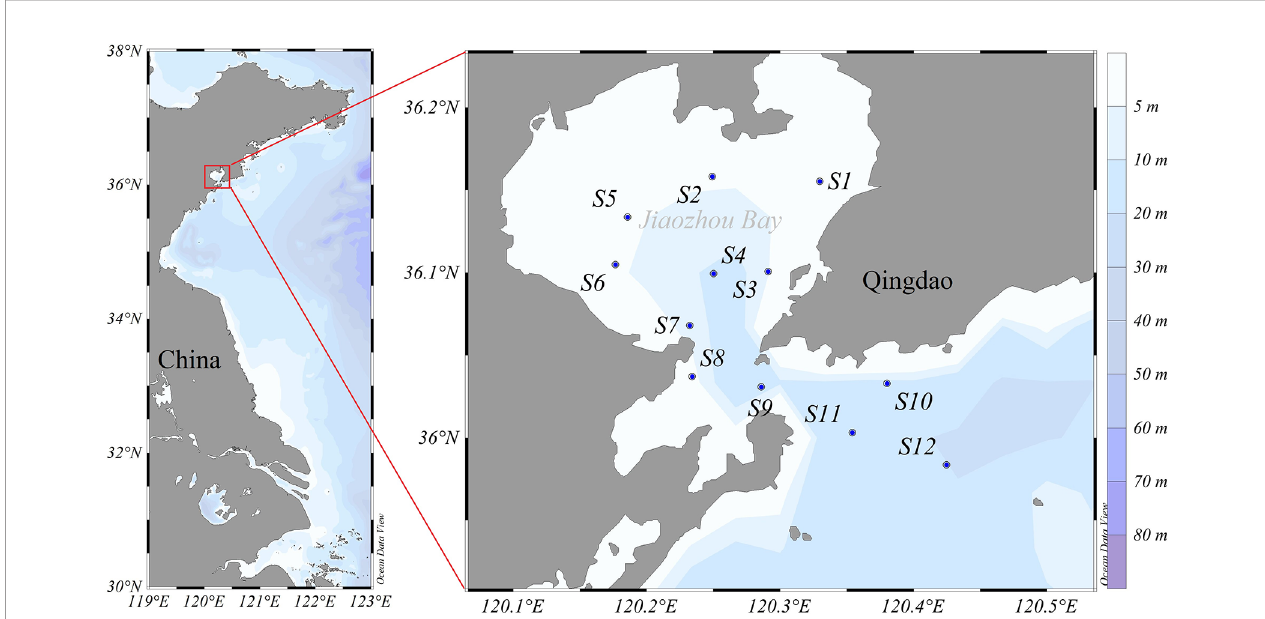
FIGURE 1 | Map of Jiaozhou Bay and the location of the sampling